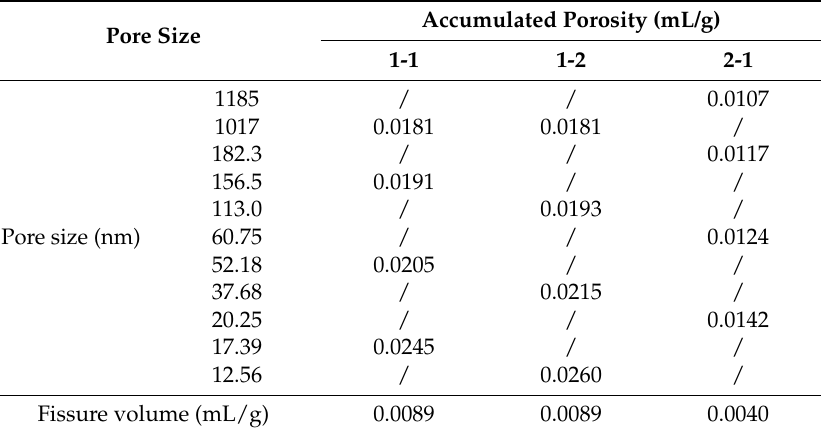
Table 5. Pore sizes and accumulated pore volumes